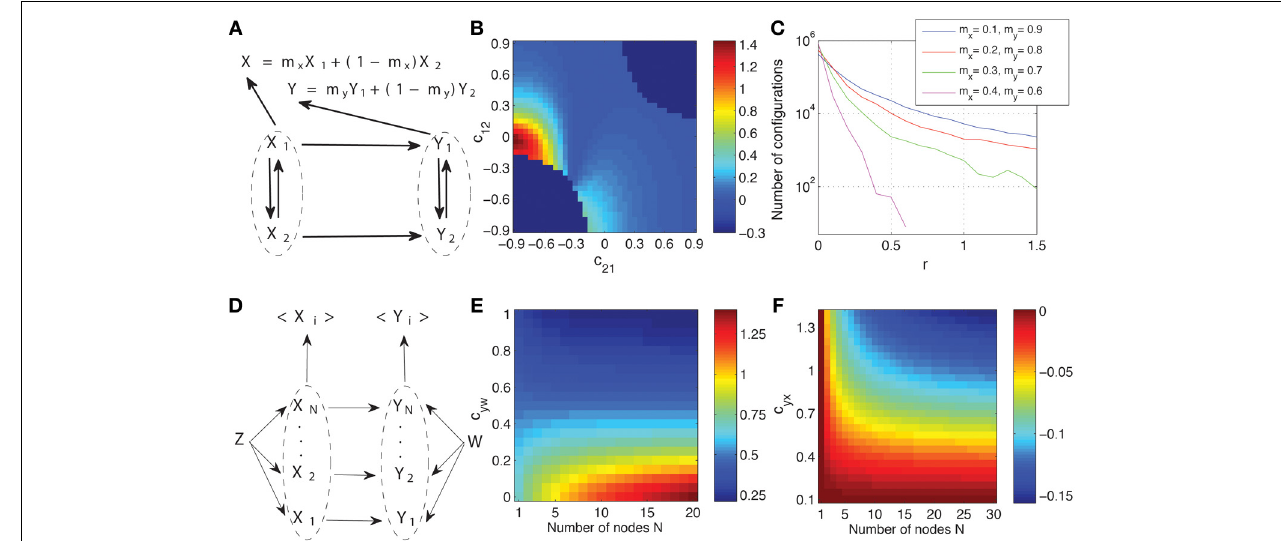
FIGURE 8 | Effects of spatial aggregation on Granger causality. (A) Causal graph representing two areas composed each of two processes and from which signals are recorded as a weighted sum. See the text for details of how a system compatible with the graph is generated as a multivariate linear Gaussian autoregressive process. (B) Dependence of the relative magnitude r of the inconsistent positives of Granger causality (Equation 15) on the space formed by coupling coefficients between X 1 and X 2 . (C) Number of configurations with a given value r for all stationary configurations in the space of the parameters c 11 , c 22 , c 12 , and c 21 and for different weights